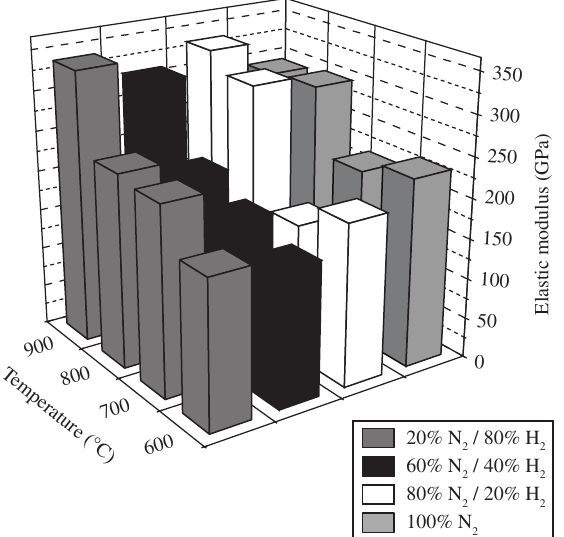
Figure 7. Elastic modulus as a function of temperature and gaseous mixture, obtained at 250 nm in depth, for all titanium working conditions.